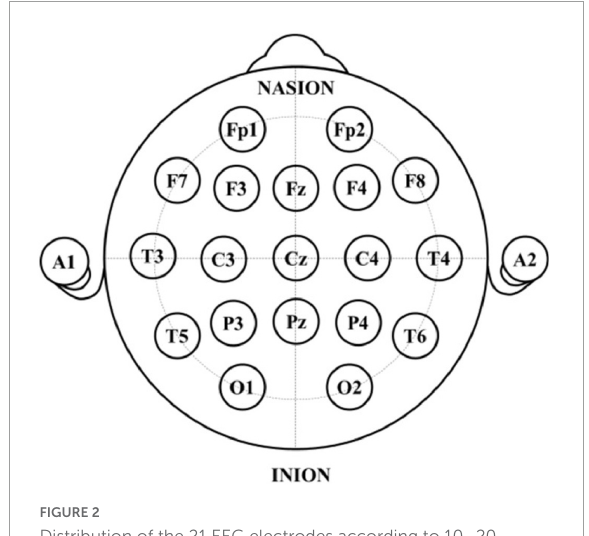
FIGURE2 Distribution of the 21 EEG electrodes according to 10–20 system.